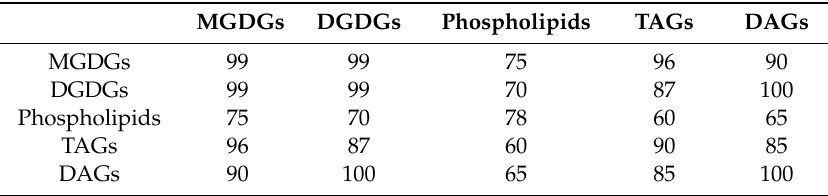
Table 2. Percentage of positive correlations between different lipid subclasses. MGDGs DGDGs Phospholipids